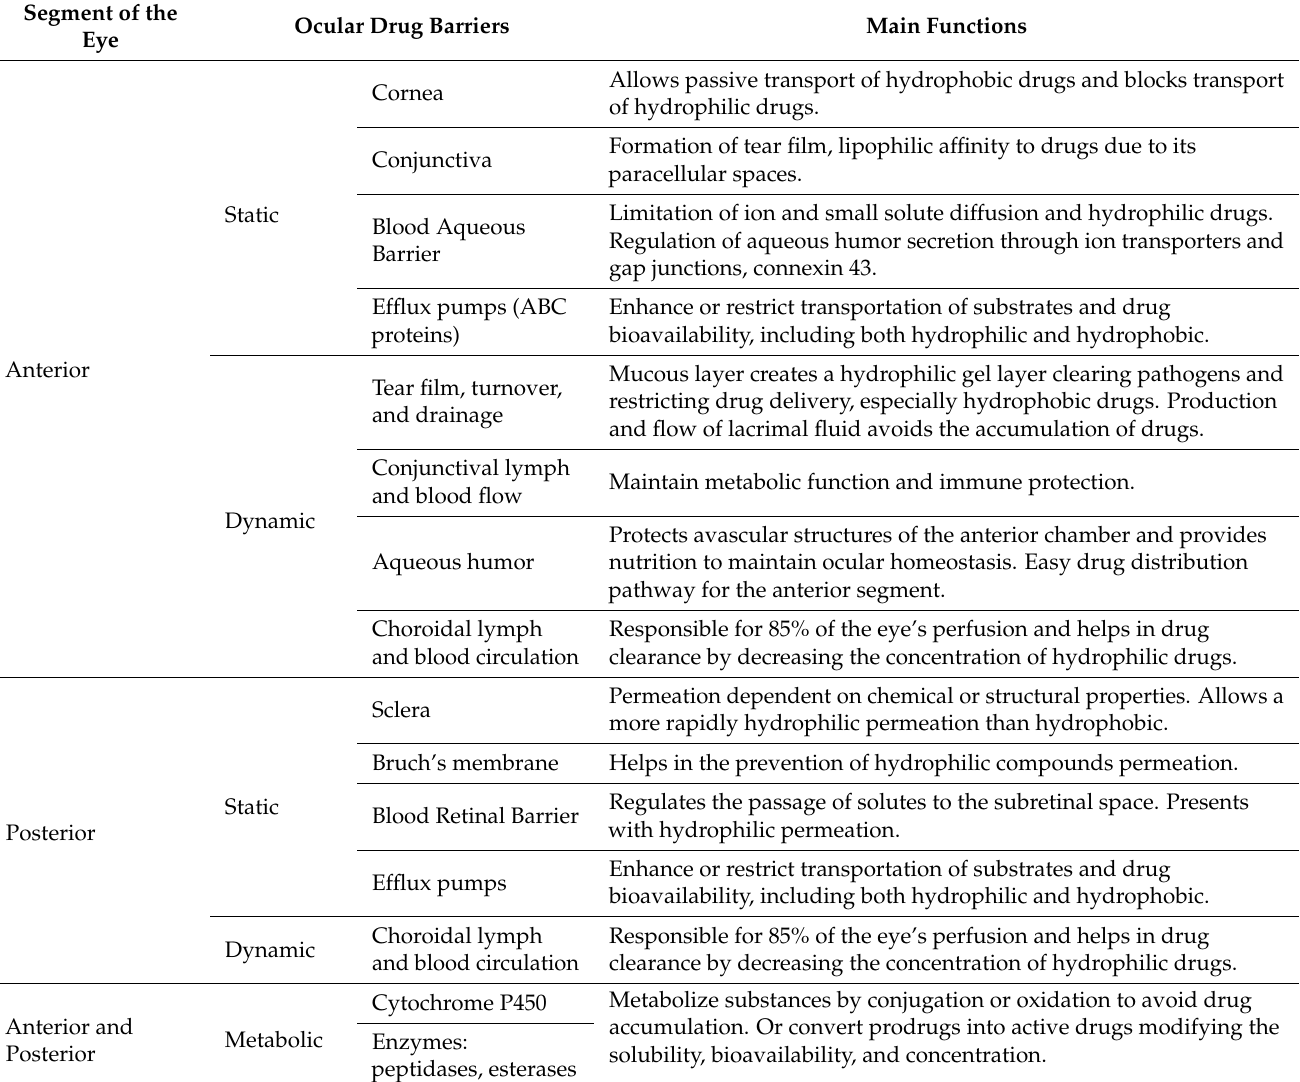
Table 1. Summary of the different ocular barriers and their main